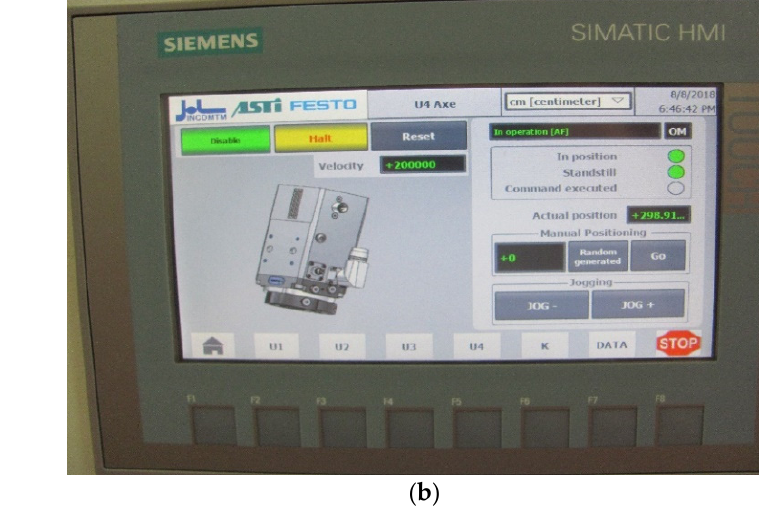
Figure 12. HMI display ( a ) HMI display installed on the command-and-control panel; ( b ) b-HMI display for command and control of the MMI4D system.